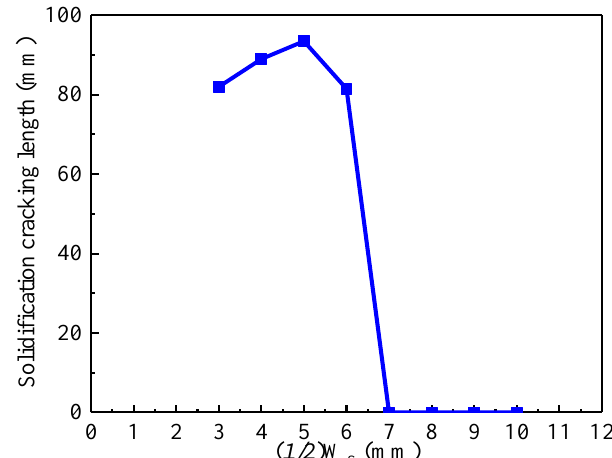
Figure 5. E ff ect of ( 1 / 2 )W S on the solidification cracking length during laser welding at a welding speed Figure 5. Effect of ( 1/2 )W S on the solidification cracking length during laser welding at a welding of 1.0 m / min. speed of 1.0 m/min.